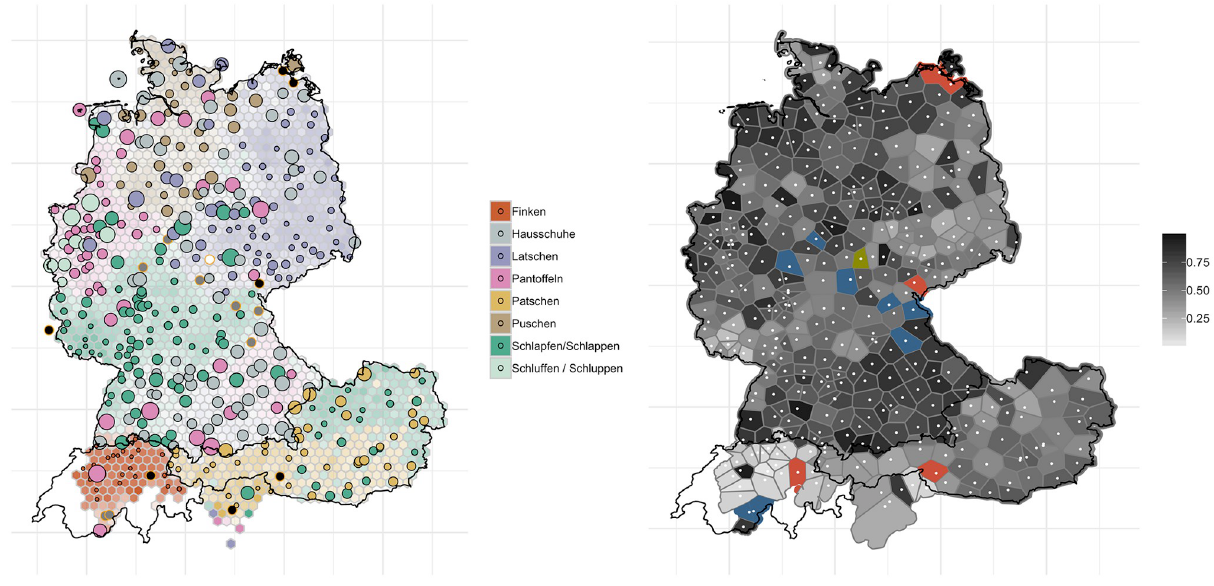
Fig 6. Variant and degree of change maps for